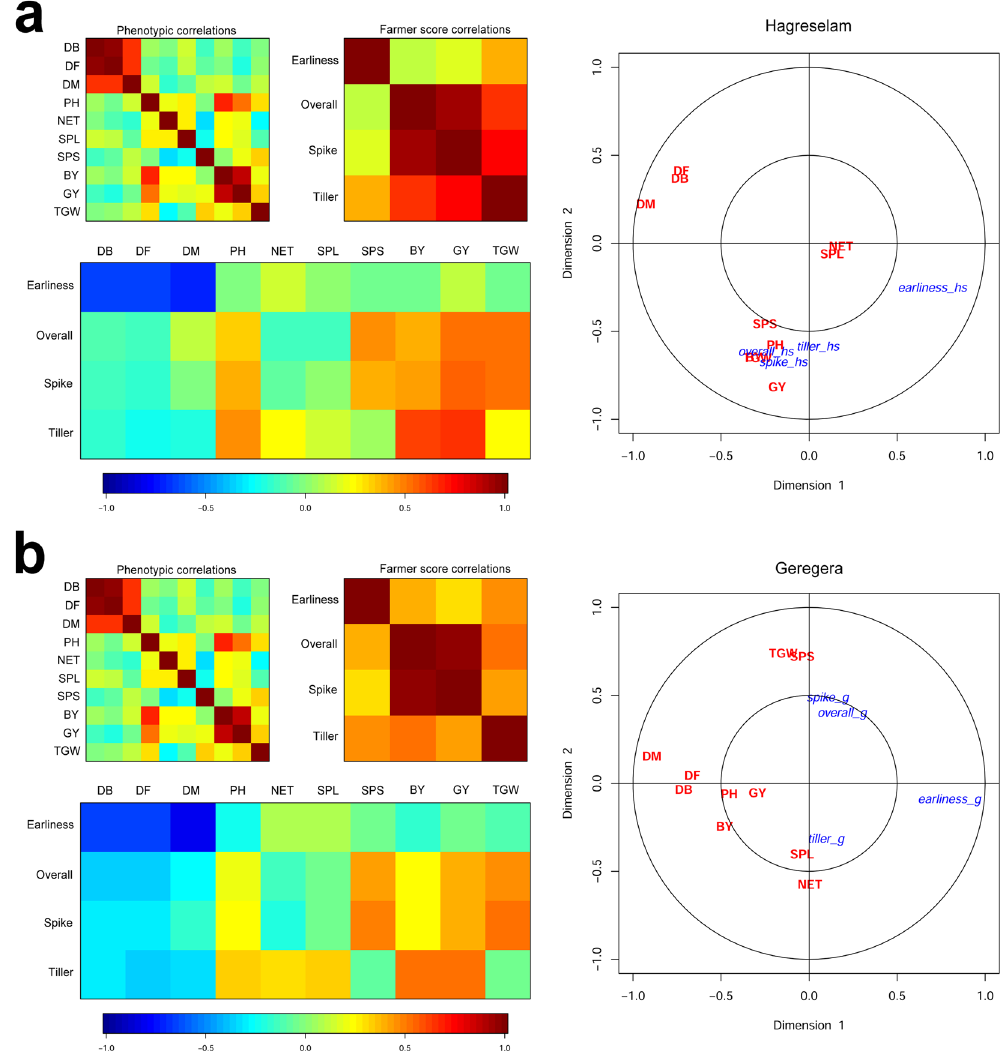
Figure 3. CCA reporting linear combinations of phenotypes and farmers’ evaluations in the two locations. ( a ) CCA for Hagreselam. On the left, phenotype correlations, farmer score correlations and cross-correlations according to the color scale below (blue to red, increasing correlation − 1 to 1). On the right of the panel is a biplot of the original variables in the first two dimensions of the CCA space. The agronomic measures are shown in red, farmer scores are shown in blue. ( b ) CCA for Geregera, reported as in panel (a). The combination of metric traits and farmer scores is different across